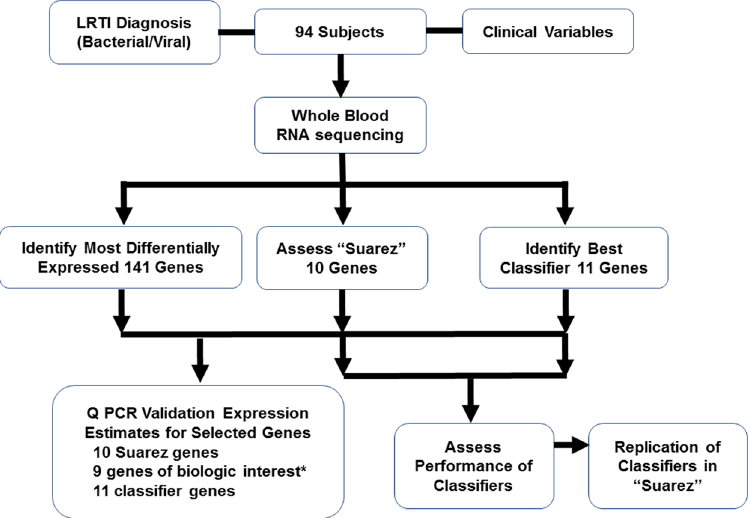
Figure 6. Flow chart of the analysis of different gene sets derived from RNA sequencing data from 94 subjects with confirmed bacterial-involved or non-bacterial LRTI selected for RNAseq interrogation. We first assessed expression of 10 genes identified by Suarez et al . to be differentially expressed comparing bacterial to viral infections. We next identified the 141 most differentially-expressed genes, as defined by statistical differences in bacterial vs. non-bacterial LRTI. Separately, we used a pathway-based approach to develop a novel gene expression classifier for discriminating bacterial vs. non-bacterial LRTI. * An additional 9 genes of biologic interest were selected from the 141gene set after considering the 10 Suarez genes. Validation of RNAseq-based expression estimates for selected genes, of particular biological interest, was attempted by qPCR. Finally, performance of the novel 3 pathway-based 11 gene classifier was assessed in our